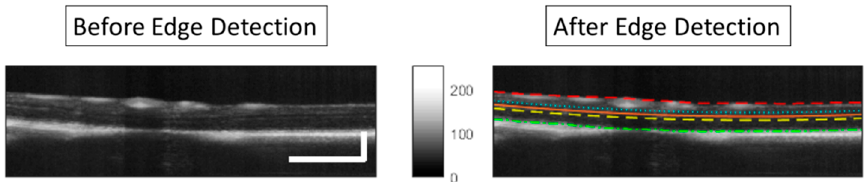
Figure 16. The left image is segmented, and the boundaries on the right. The boundaries displayed are the vitreous-ILM, IPL-INL, INL-OPL, OPL-ONL, ONL-RPE boundaries. Scale bars represent 300 μ m. To obtain a L/H 2 tomogram, Pathlengths 1 and 2 are divided at every voxel position. With this approach, the segmentation output can be superimposed on the volume to sort the retinal L/H 2 values into their corresponding layers (Figure 17).